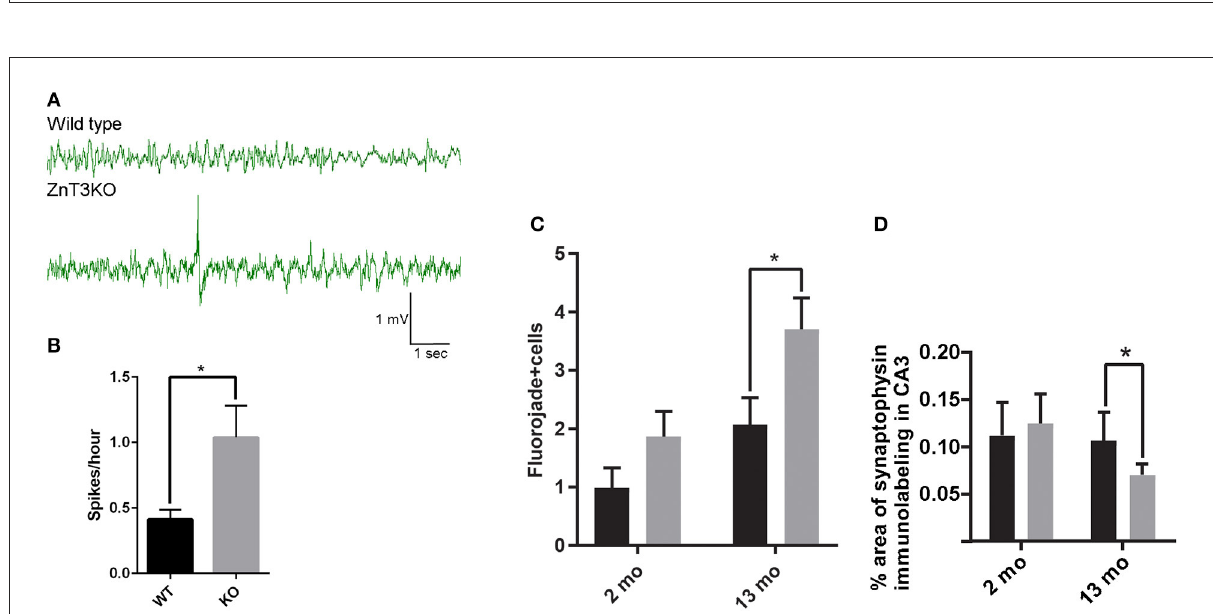
FIGURE7 ZnT3KO mice exhibit elevated epileptiform spiking activity, fluorojade + cells, and reduced synaptophysin expression. (A) Representative EEG of 2-month-old WT and ZnT3KO shows spiking epileptiform activity in ZnT3KO. (B) 2-month-old ZnT3KO have an elevated rate of spikes per hour. n = 3. EEG data during movement detected by implanted Neurologger recording device was manually removed and raw EEG data was bandpass filtered from 1 to 80Hz. Spike threshold was a peak amplitude 2.5X greater than the average baseline. (C) Image analysis of immunolabeling in hippocampus CA3 region shows an age-dependent decrease in synaptophysin protein levels in ZnT3KO. 2 mo: WT, n = 8, KO, n = 9; 13 mo: n = 6; scale bars 20 µ m; one field from each subject was imaged at 63X, quantified using the Axiovision (Zeiss) automated measurement program and the average percent area calculated. (D) Quantification of Fluorojade + cells counted in the CA3 region of the hippocampus show that there is an increased number in 13-month-old KO. 2 mo: WT, n = 11, KO, n = 9; 13 mo. WT, n = = 9, ZnT3KO n = 11; the CA3 region was imaged at 20X magnification using the Mosaic tool in Axiovision to image and stitch together adjacent fields and the number of Fluorojade positive cells were counted by an experimenter blinded to subject conditions. * p < 0.05. Data were analyzed by two-tailed unpaired t -test. Error bars indicate the mean ±